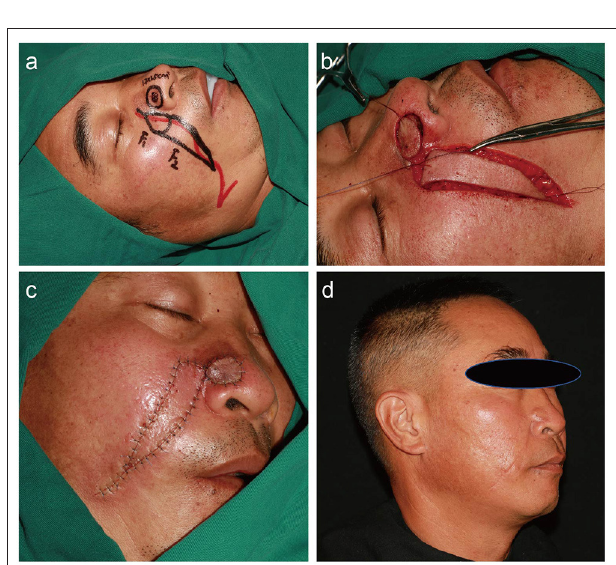
FIGURE 3 | A 51-year-old man with a history of basal cell carcinoma on the right ala for 7 months. (a) Preoperative design. The red line shows the location of the facial artery. (b) Dissection of the round rotational flap and V–Y advancement island pedicle flap. (c) Flaps are sutured into the defect